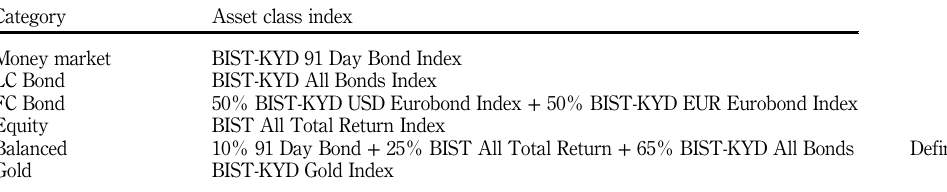
Table I. Definition of asset